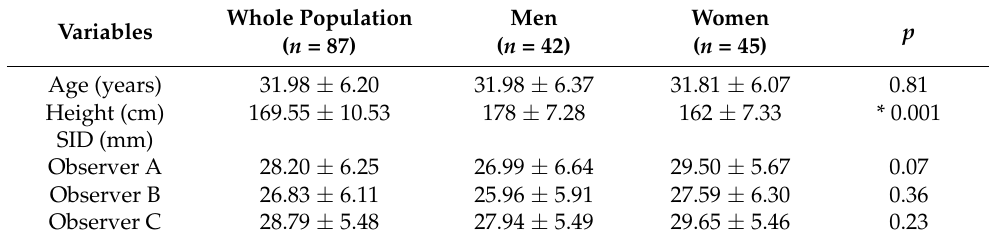
Table 1. Clinical characteristics and symphysis–ischial spine distance (SID) measurements made for the whole population, and by sex or observer. The data are provided as the mean and standard deviation (SD); * p < 0.05.